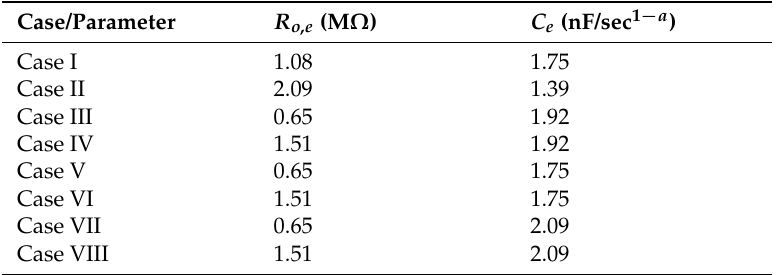
Table 11. Electrode Cole parameters values for different cases, a e = 0.942.